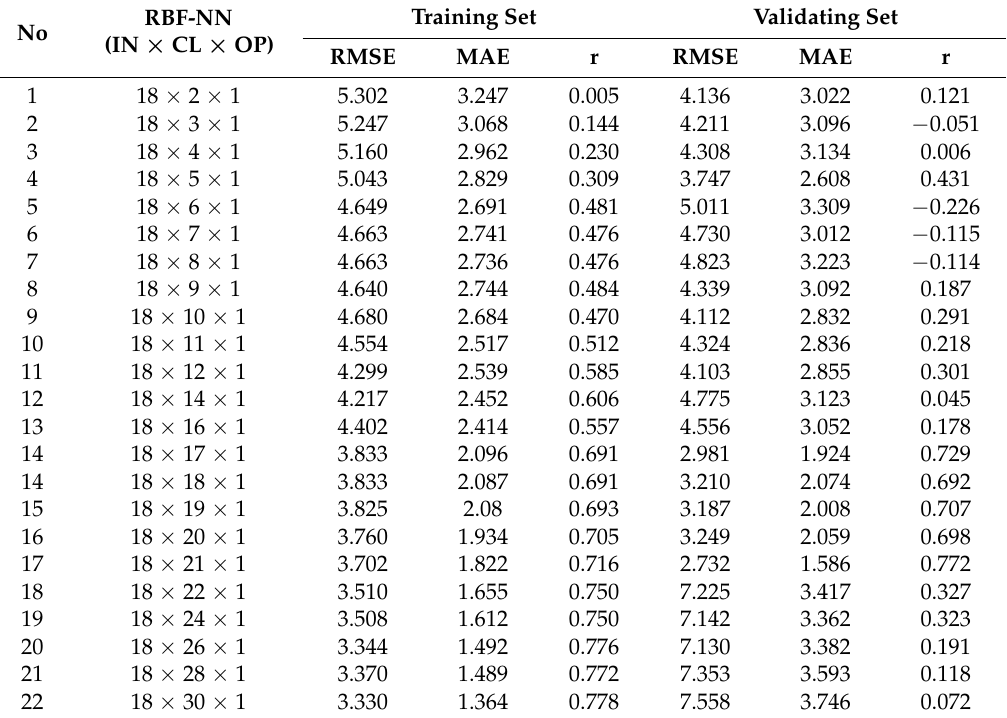
Table 3. Performance of RBF-NN versus its clusters (IN: Input neuron; CL: Number of clusters; OP: Output).